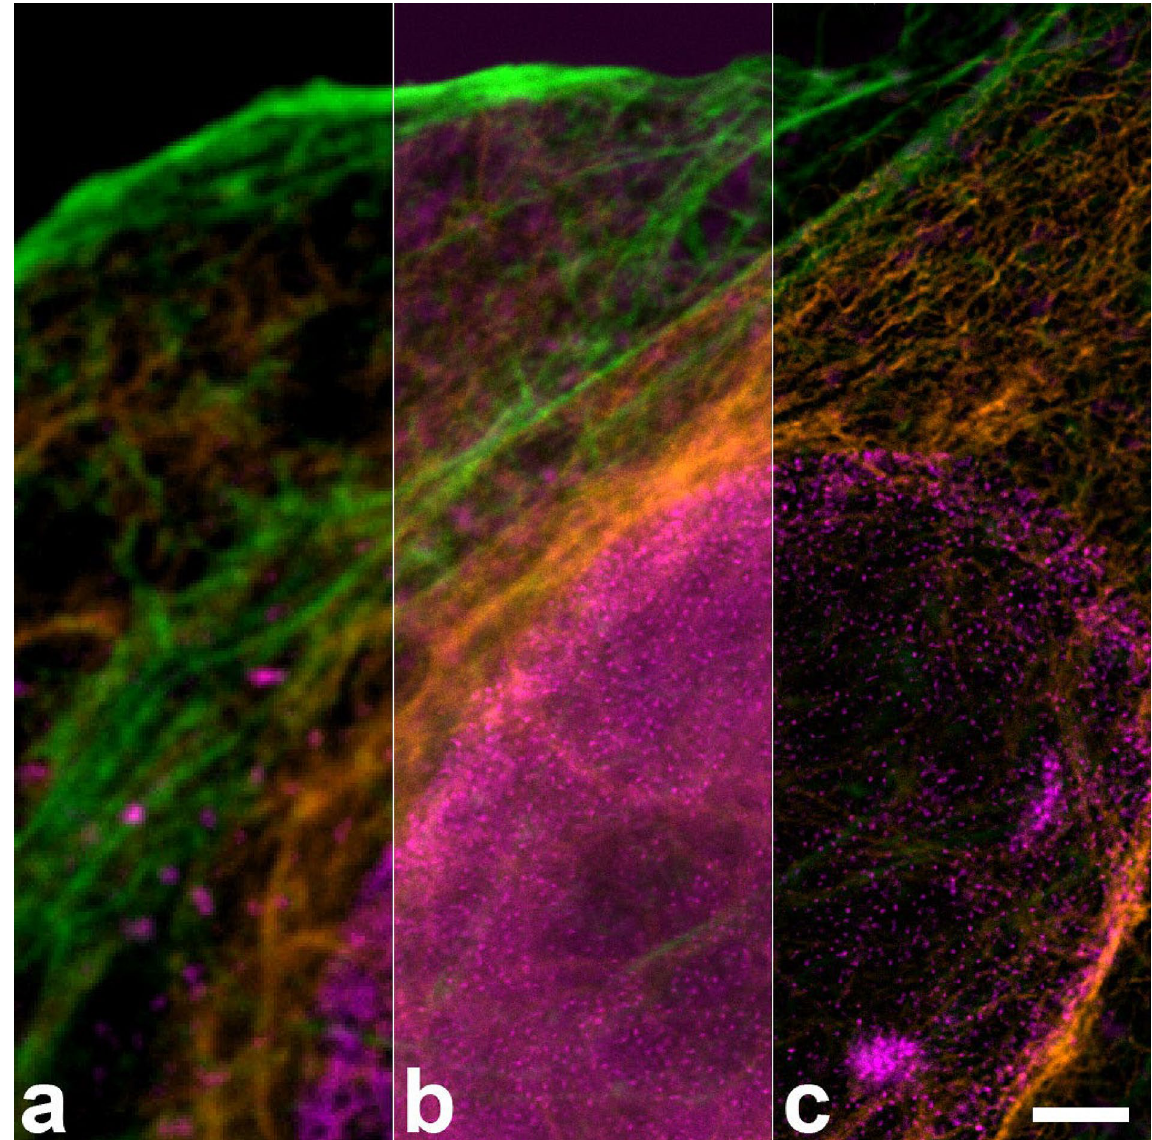
Figure 3. Three color image with spectrally separated SPY555-actin (green) and antibody stainings against vimentin (Alexa Fluor 594, orange) and nuclear pores (CF680R, magenta), all depleted with 775 nm. ( a ) confocal, ( b ) STED ( c ) Tau-STED. This dye combination could be supplemented with e.g. Abberior STAR 635P to obtain four spectrally separable fluorochromes. Scale bar: 2 µm. The three original full images are shown in Supplemental Fig.